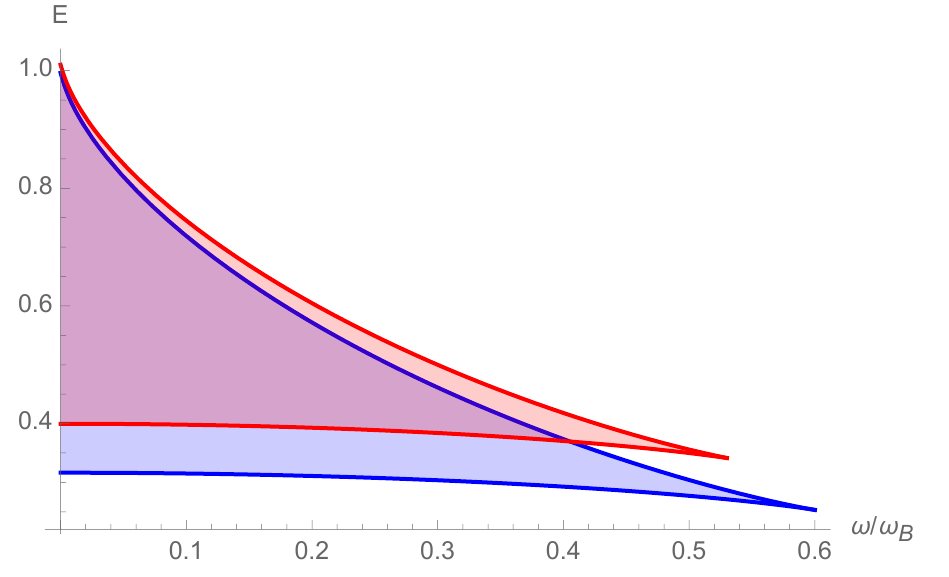
Figure 3 . B = 1, (cid:27) Q = 0 : 25, (cid:26) = 1, ! B = (cid:26)B= ( (cid:15) + p ) with (cid:28) = 5 (red) (cid:28) = 10 (blue). There is also a region not pictured with 3 real solutions, however, 2 are unstable.